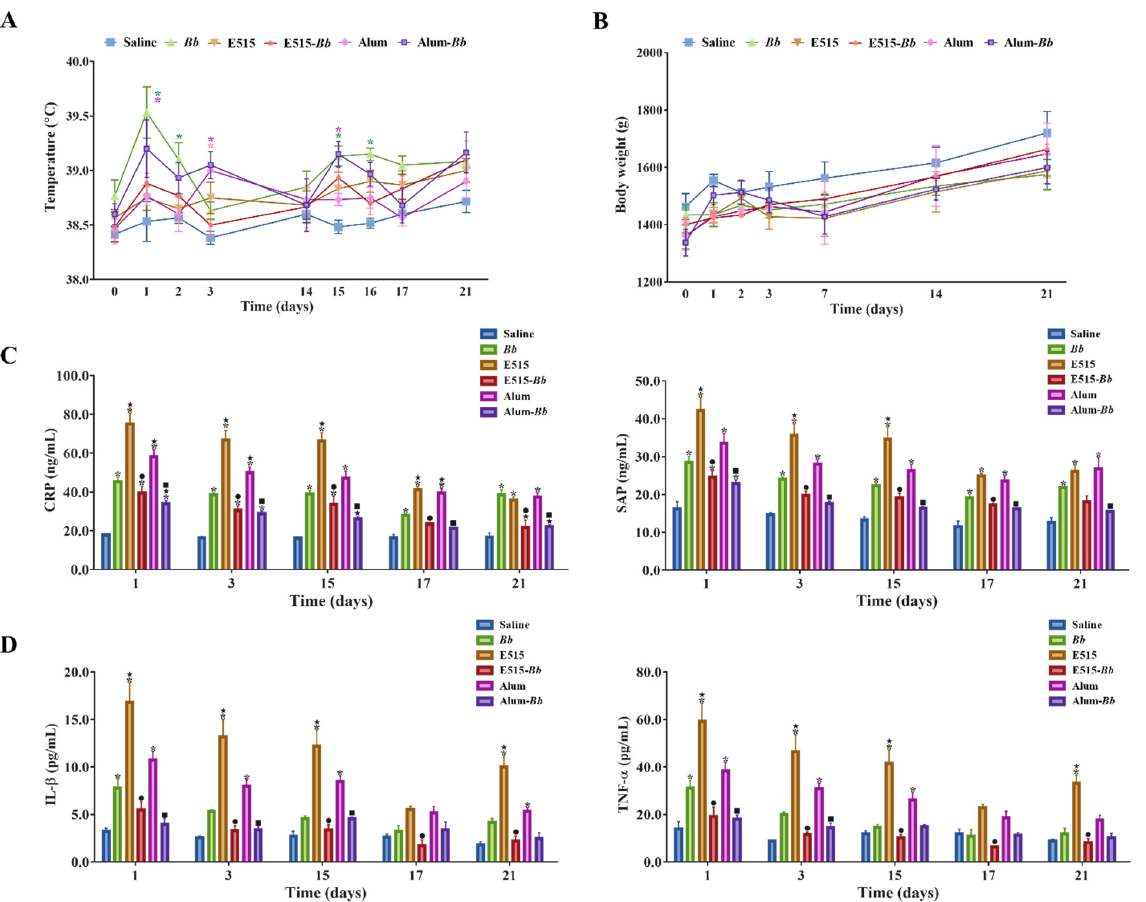
Figure 1. Safety estimation of the adjuvanted Bb vaccine. Rabbits ( n = 9/group) were subcutaneously (s.c.) injected twice at a 2-week interval with 2 mL of saline, inactivated Bb antigen (1.2 × 10 10 CFU/mL), E515 only, Alum only, or inactivated Bb antigen adjuvanted with E515 (E515- Bb ) or Alum (Alum- Bb ). ( A , B ) Temperature and weight changes at different time points after immunization (* p < 0.05 compared with the saline group, the colors of * are in line with the indicated groups). ( C ) I Serum levels of acute phase proteins (CRP and SAP). ( D ) Concentrations of serum cytokines (IL-1 β and TNF- α ). Data are presented as the mean ± SE. * p < 0.05 vs. Saline group, (cid:70) p (cid:4) p < 0.05 vs. Bb group, • p < 0.05 Bb vs. E515- Bb group, < 0.05 Bb vs. Alum- Bb